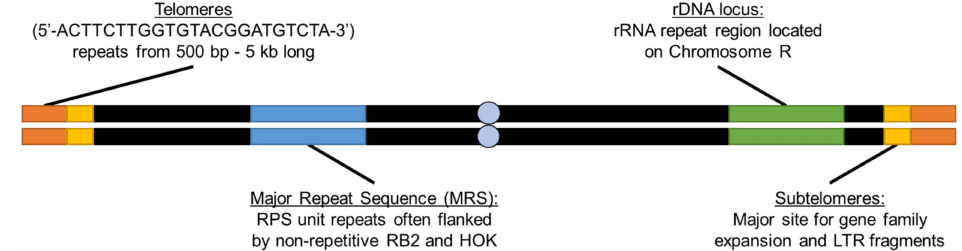
Figure 1. Major classes of genetic repeats in Candida albicans . C. albicans contains four major categories of repeat sequences: the telomeres that contain multiple copies of a 23 bp repeat; the Major Repeat Sequence (MRS) composed of repetitive sequence (RPS) repeats; the rDNA locus, which encodes the polycistronic rRNA transcripts; and the subtelomeres, a telomere-proximal region containing transposable elements and a gene family expansion. Centromeres are indicated by grey